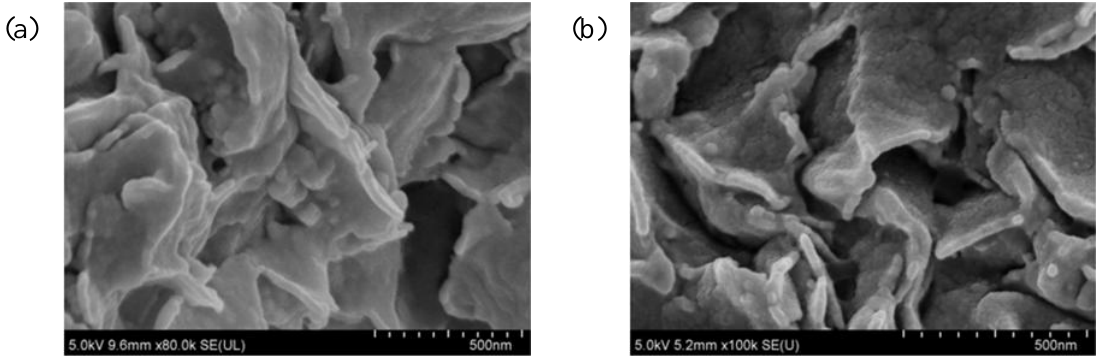
Figure 12. SEM microphotographs of brittle fractures: EP with the addition of 1.5% BP1 and 1.5% I-HS-P3 (EPBP1IHSP3-3.0) ( a ); and EP with the addition of 2.25% BPOSS and